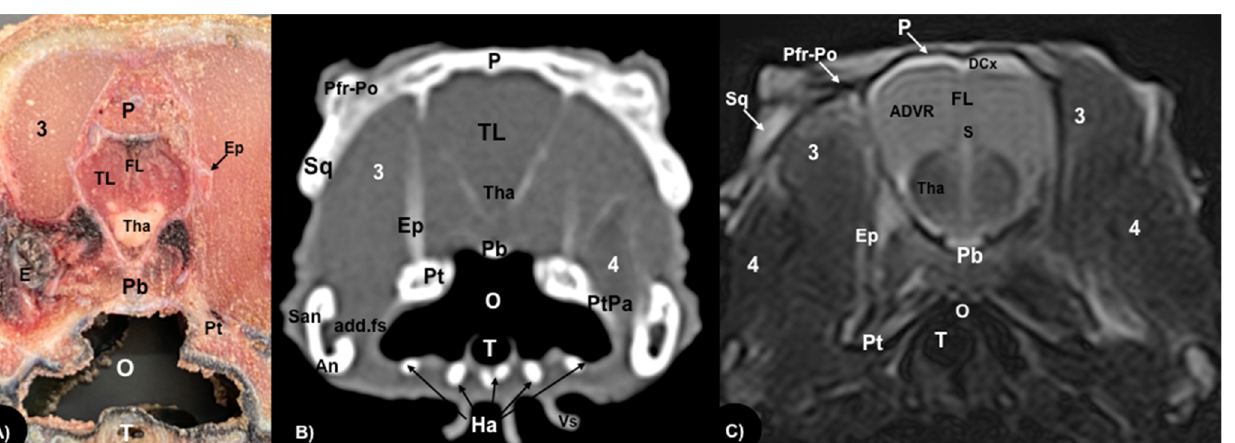
Figure 4. Transversal gross ‐ section ( A ), CT bone window ( B ), and MRI in T2W ( C ), images of the head of rhinoceros iguana at the level of the frontal bone corresponding to line III in Figure 1. 3: Musculus adductor mandibulae externus medialis . P: Parietal bone. Pfr ‐ Po: Postfrontal ‐ Postorbital bone. TL: Telencephalon. FL: Fissura longitudinalis cerebri . DPR: Dorsal Pallium Rostral Part. Tha: Thala ‐ mus. E: Eyeball. Sp: Sphenoid bone. Pt: Pterygoid bone. J: Jugal bone. Pa: Palatine bone. O: Oral cavity. 4: Musculus adductor mandibulae externus Pars superficialis. Mx: Maxillary bone. cn.tt: Canini ‐ form tooth. Np: Nasopharyngeal duct. Co: Coronoid. San: Surangular bone. An: Angular bone. 2: Musculus intermandibularis + Musculus geniohyoideus + Musculus hyoglossus + Musculus pterygoideus + Musculus omohyoideus + Musculus sterohyoideus + Musculus ceratohyoideus. T: Trachea. Ha: Hyoid ap ‐ paratus.